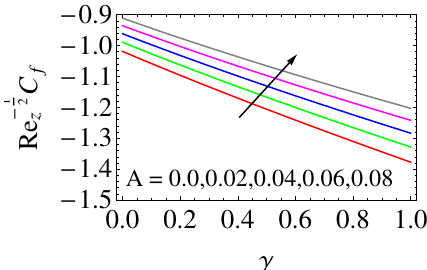
Figure 9. Influence of velocity slip ( A ) parameter on skin friction.